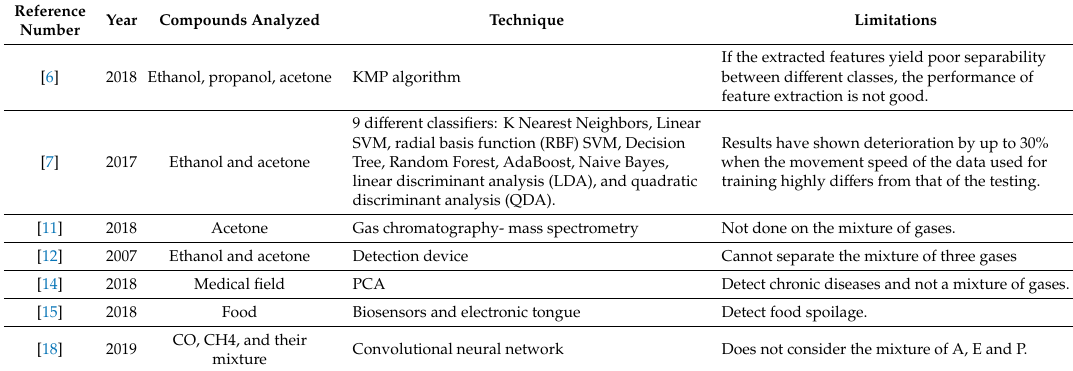
Table A1. Summary of the literature